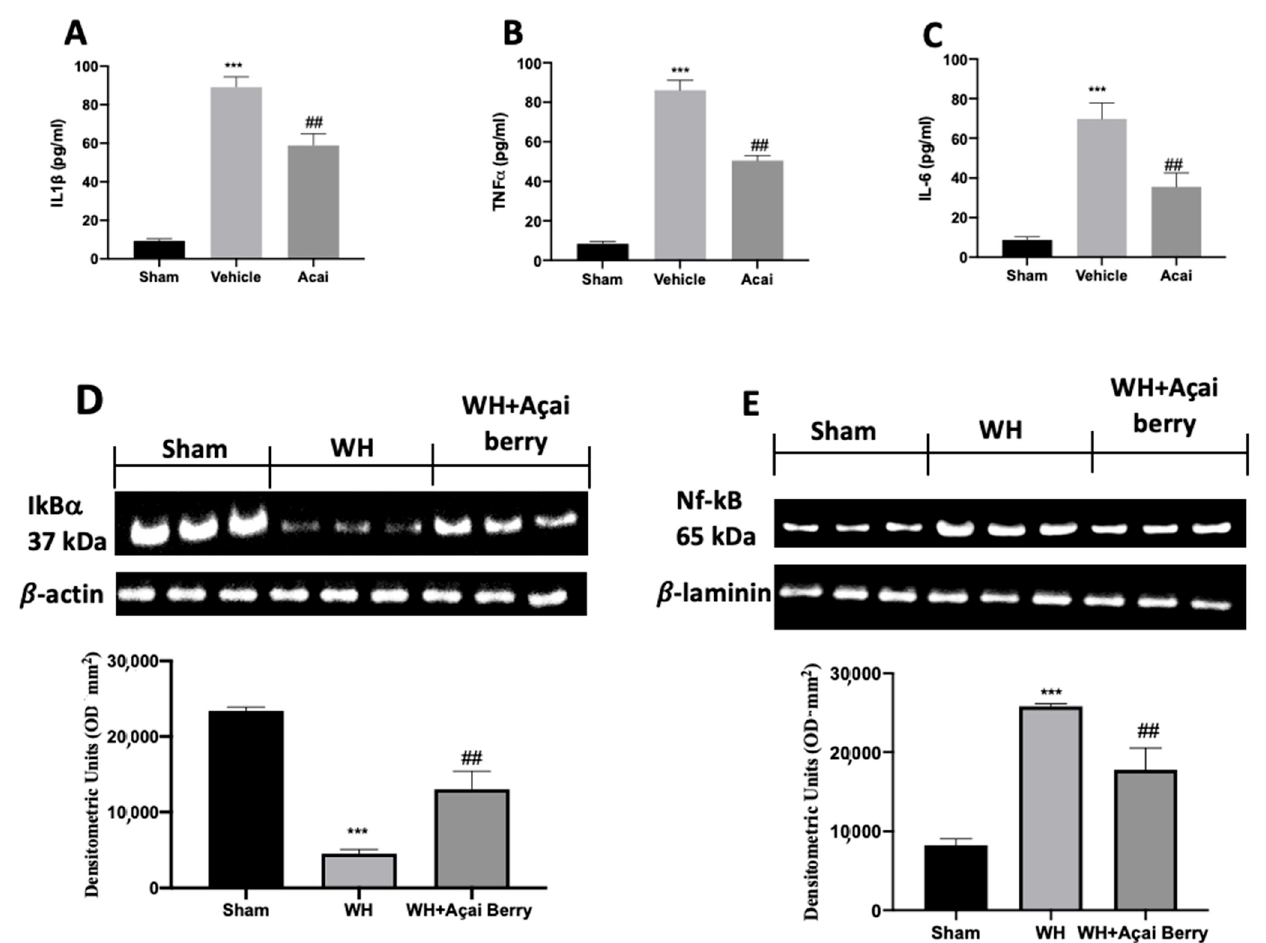
Figure 6. Expression of inflammatory cytokines: IL-1 β ( A ), TNF- α ( B ), and IL-6 ( C ). Western blot analysis for I κ B- α ( D ) and NF- κ B ( E ). A demonstrative blot of lysates with a densitometric analysis for all animals is shown. Data are expressed as the mean ± SEM of N = 6 mice/group. *** p < 0.001 vs. sham; ## p < 0.01 vs. WH, ### p < 0.001 vs. WH.